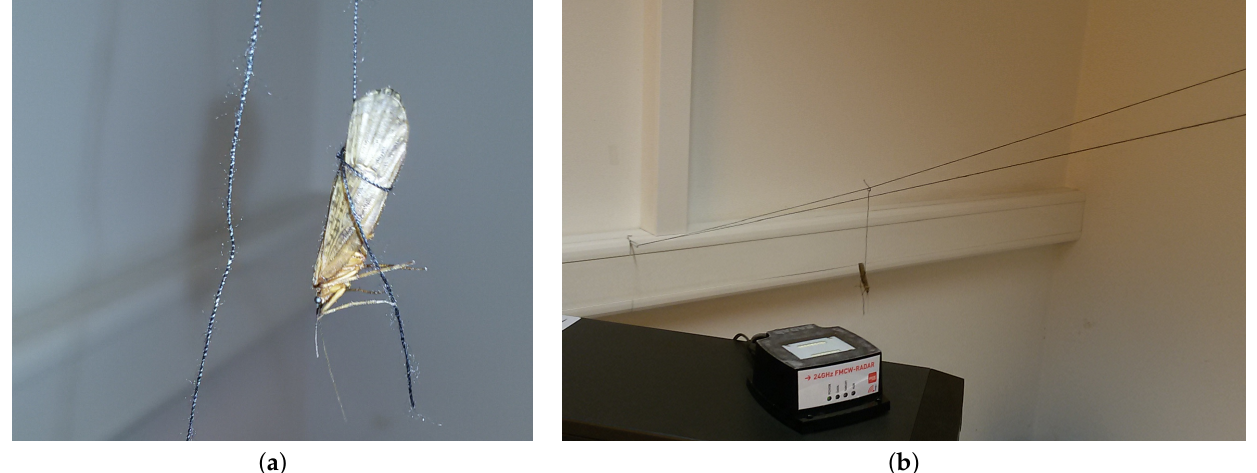
Figure 2. Phryganea grandis : ( a )—tied with a thread, ( b )—placed above the